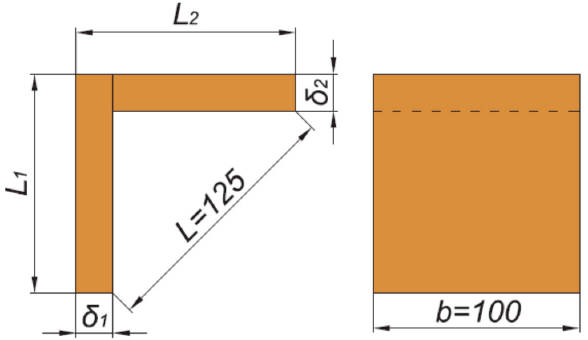
Figure 2. Type and dimensions of the tested samples [78].